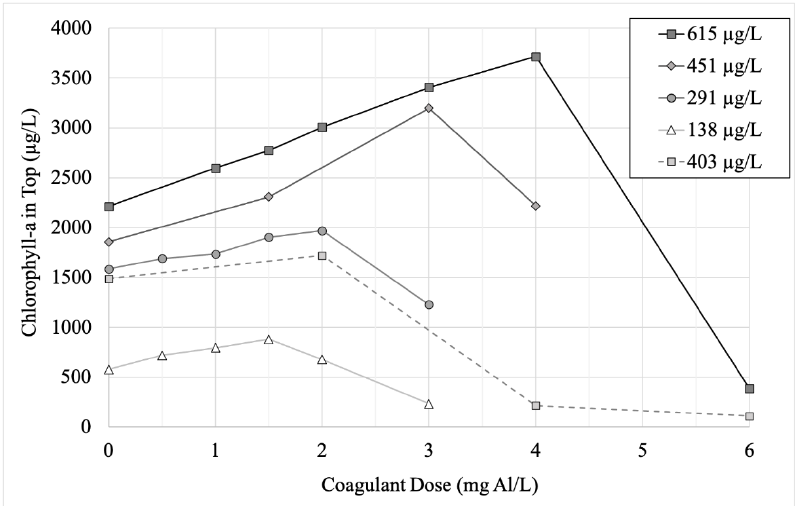
Figure 4. Mean ( n = 2) chlorophyll-a concentration (in micrograms per liter) in sample collected from top of experimental unit following treatment of varying doses of coagulant (aluminum sulfate, in mg Al/L) at five different initial concentra- tions of cyanobacteria. Three of the chlorophyll-a concentrations (451 µg/L, 291 µg/L and 138 µg/L) were created by dilut- ing the raw sample collected for Stage 2 (615 µg/L), while the fifth concentration (403 µg/L) is the data from the raw sample for Stage 1.